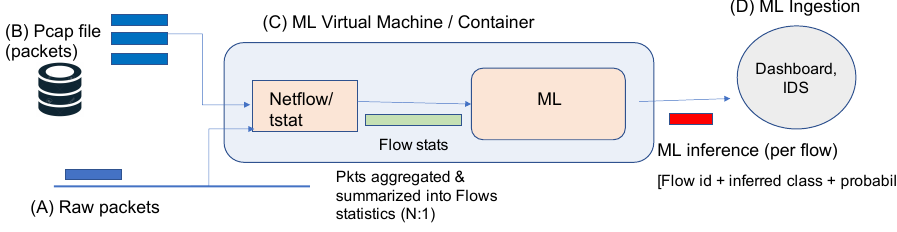
Figure 2. ML processing model in